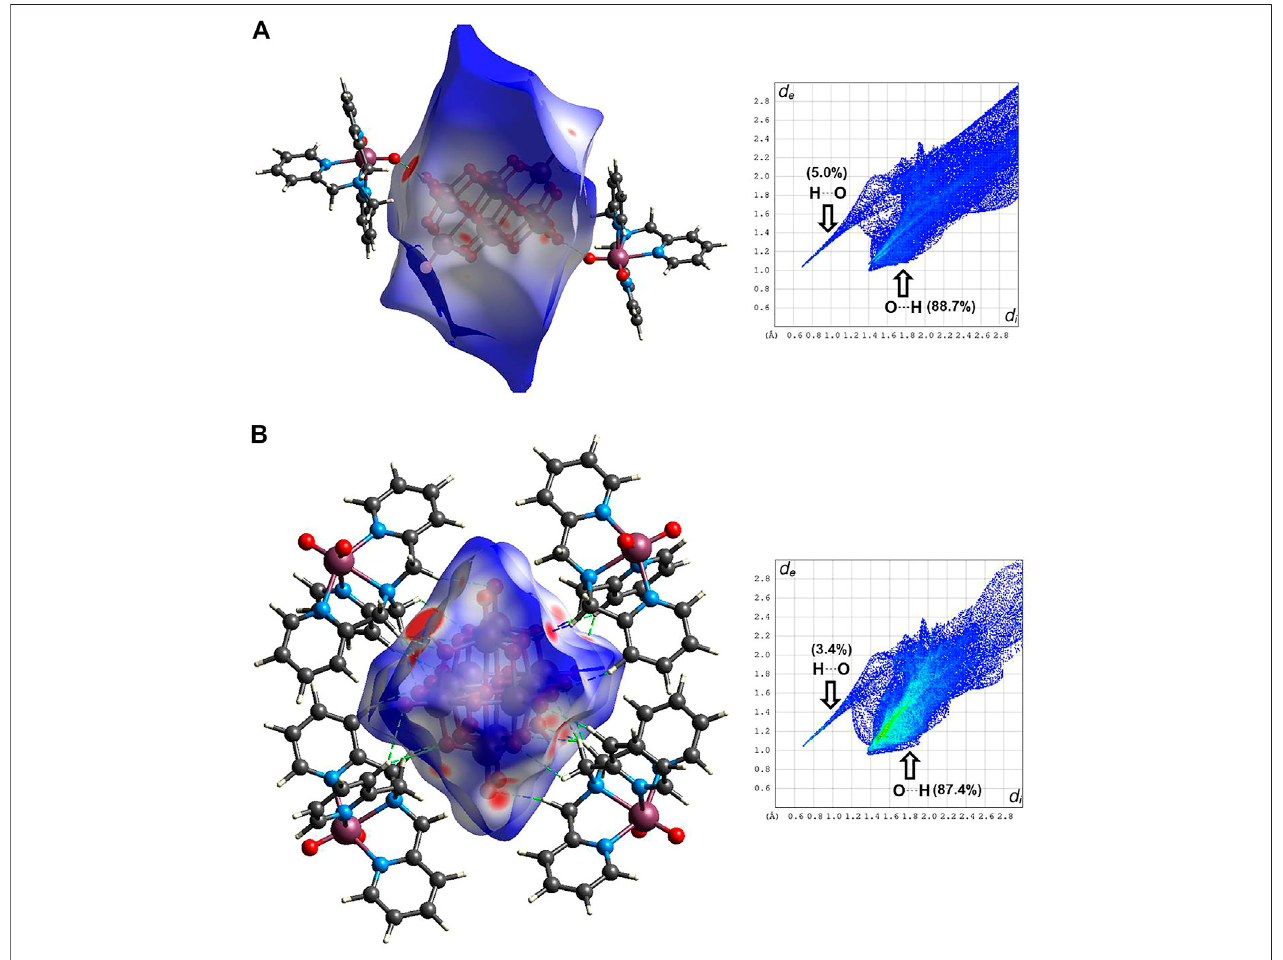
FIGURE8| Hirshfeld surfaces (left)and fi ngerprintplots ofnoncovalent interactions (right) mapped withd norm parameter of (A) the representation of Compound1 forming hydrogen bonds connecting both species of V(V), and (B) the asymmetric unit showing to the diprotonated decavanadate unit and four dioxidovanadium(V)- tpma